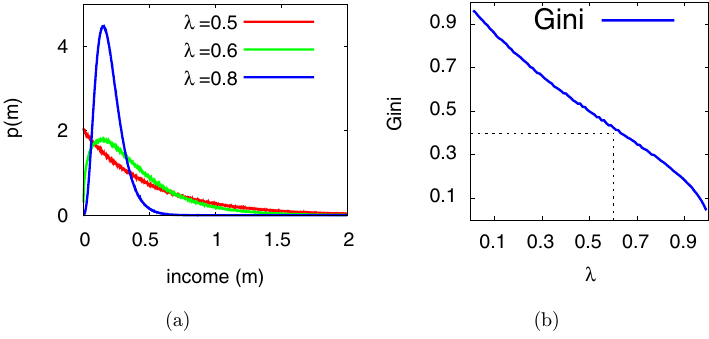
Fig. 4. (a) The distribution of income of the agents who are getting money in return, is shown when the saving propensities of the agents are constants. (b) The measurement of inequality in terms of Gini- index are shown for di®erent values of saving propensity (see also Ref. 18 for the fairness bound of Gini index).